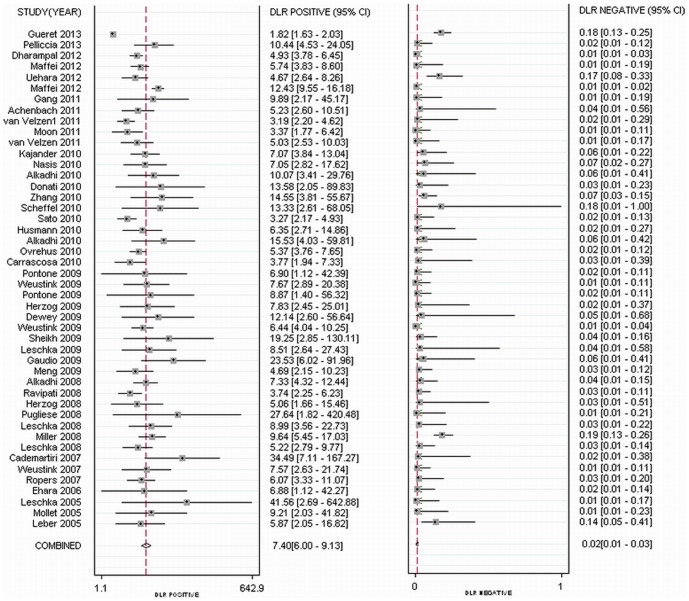
Forest plots showing positive and negative LRs at the patient level.For studies including uninterpretable results, the pooled positive LR was 7.40 (CI, 6.00, 9.13) and negative LR was 0.02 (CI, 0.01, 0.03), respectively.